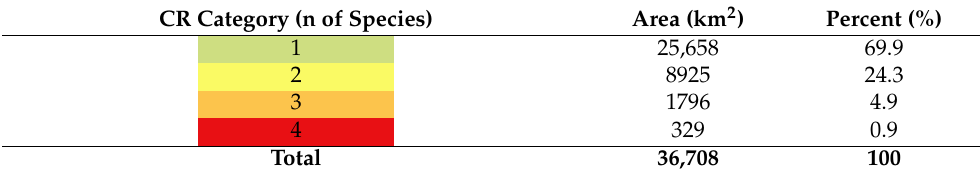
Table 2. Distributional coverage of critically endangered (CR) freshwater fish species in Greece. CR Category (n of Species) Area (km 2 )